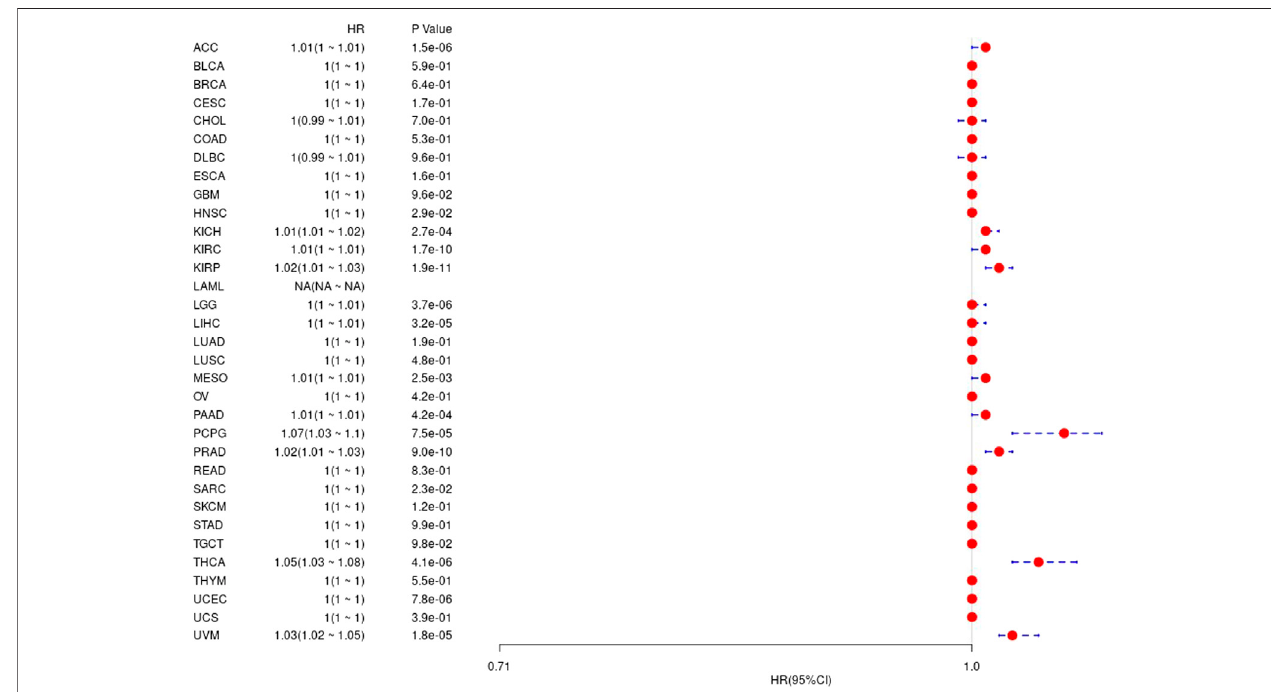
FIGURE 7 | The relationship between UBE2C gene and prognosis-free interval in TCGA tumor and nontumor.